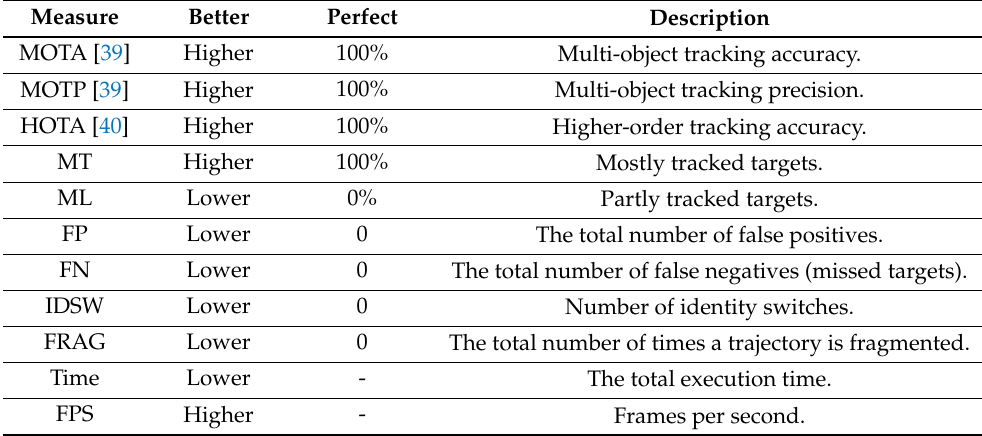
Table 3. Evaluation measures.